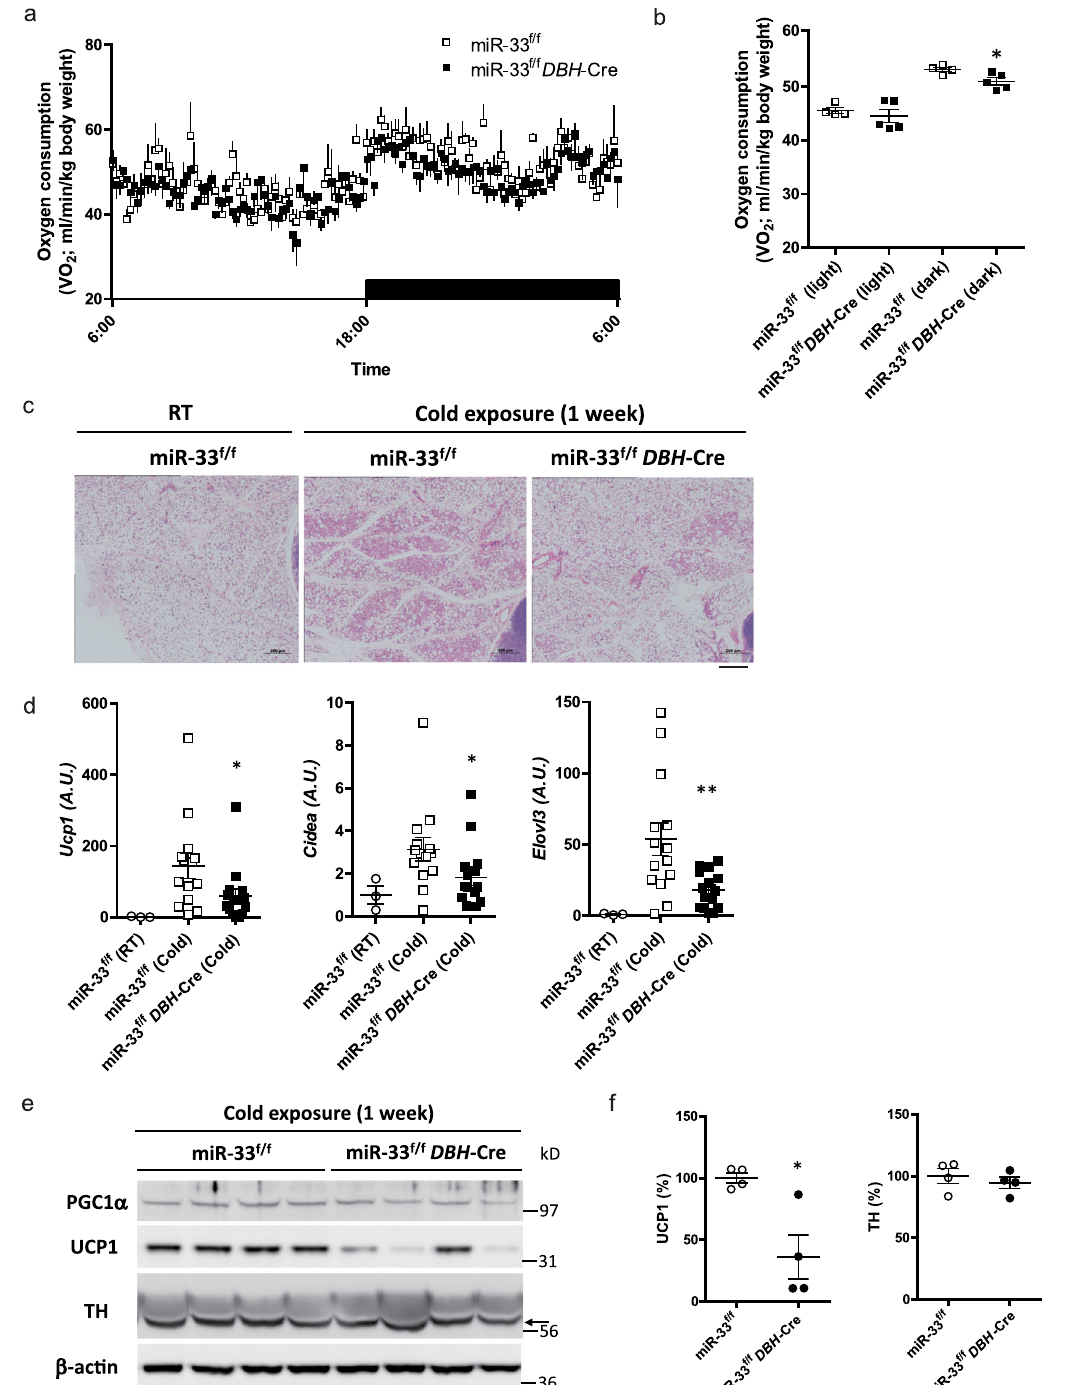
Fig. 6 miR-33 f/f DBH -Cre mice exhibit a phenotype similar to miR-33 − / − mice. a Oxygen consumption rate in miR-33 f/f and miR-33 f/f DBH -Cre mice kept at 18 °C n = 4 or 5 mice per group. b Mean oxygen consumption rate during the light and dark phase in miR-33 f/f and miR-33 f/f DBH -Cre mice kept at 18 °C. n = 4 or 5 mice per group. * p < 0.05, two-sided Mann – Whitney test. c Representative images of HE staining for inguinal WAT kept at 16 °C for 1 week in miR-33 f/f and miR-33 f/f DBH -Cre mice. n = 3, 5, 6 mice per group. Hematoxylin-strongly stained area of inguinal lymph node was taken into the picture to evaluate almost the same location in inguinal WAT. Scale bar, 200 μ m. d Quantitative real-time PCR analysis of beige adipocyte markers in inguinal WAT kept at 16 °C for 1 week in miR-33 f/f and miR-33 f/f DBH -Cre mice. n = 3 mice in miR-33 f/f mice at room temperature, n = 14, 15 mice per group at 16 °C, ** p < 0.01, * p < 0.05, two-sided Mann – Whitney test. e Western blotting analysis of PGC1 α , UCP1, TH, and β -actin in inguinal WAT kept at 16 °C for 1 week in miR-33 f/f and miR-33 f/f DBH -Cre mice. n = 4 mice per group. The arrow indicates speci fi c bands of TH staining. f Densitometry for UCP1 and TH in the inguinal WAT of miR-33 f/f and miR-33 f/f DBH -Cre mice at 16 °C for 1 week. n = 4 mice per group, * p < 0.05, two-sided Mann – Whitney test. All data are presented as mean ±